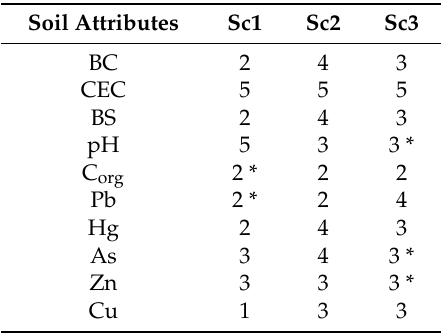
Table 7. The prediction models obtained were categorized into five groups (1 is the best and 5 the worst score) based on the guidelines given by [44], further described in Section 3.1). If the same score is obtained, the model with the higher R 2 test is marked with *. Scenario 1: Sc1 (0.6–13.3 µ